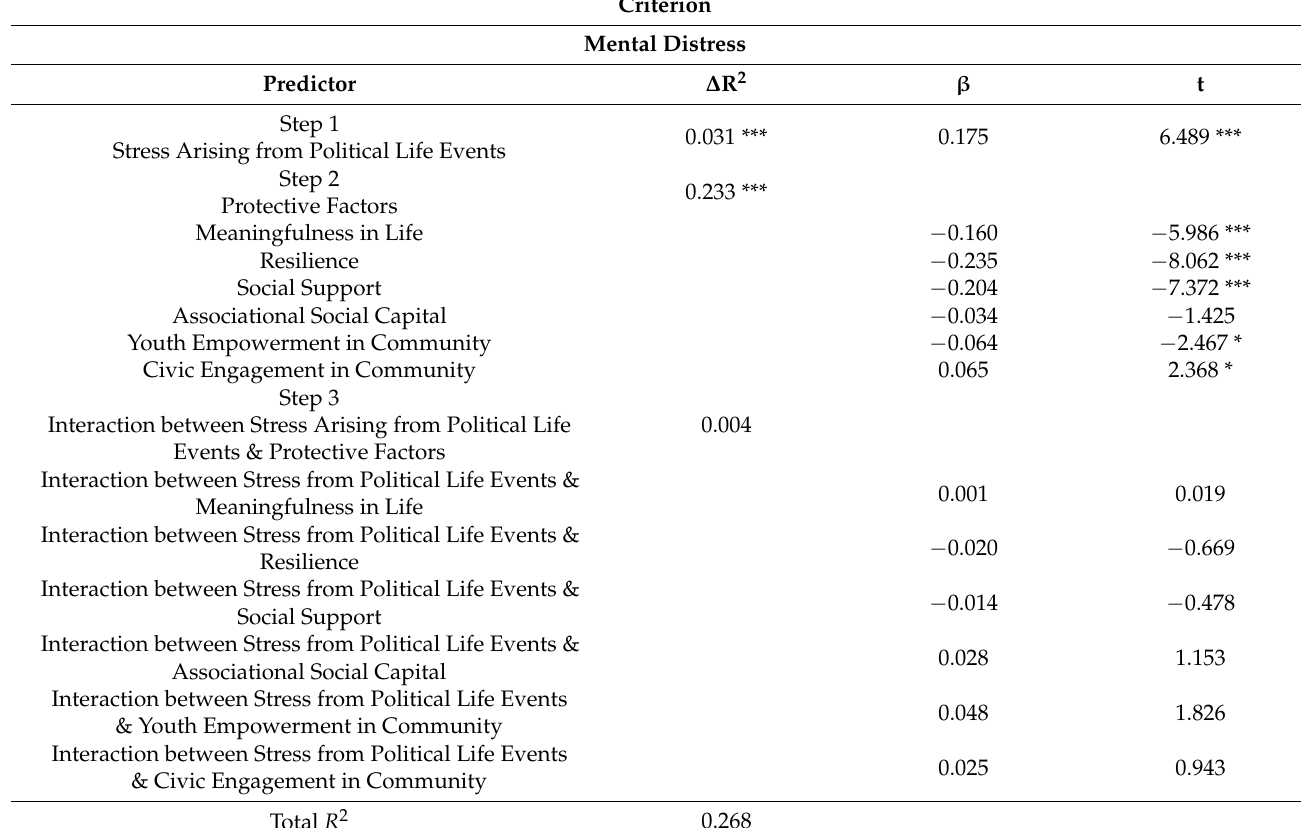
Table 3. Hierarchical regression analysis predicting mental distress from stress arising from political life events and all levels of protective